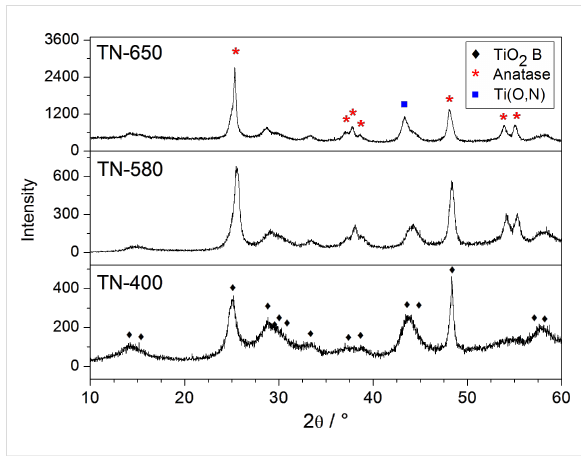
Figure 2: XRD patterns of TiO 2 nanoribbons derived from hydrogen titanate nanoribbons resulting from a heat treatment in a NH 3 (g)/Ar(g) flow at 400, 580 and 650 °C.